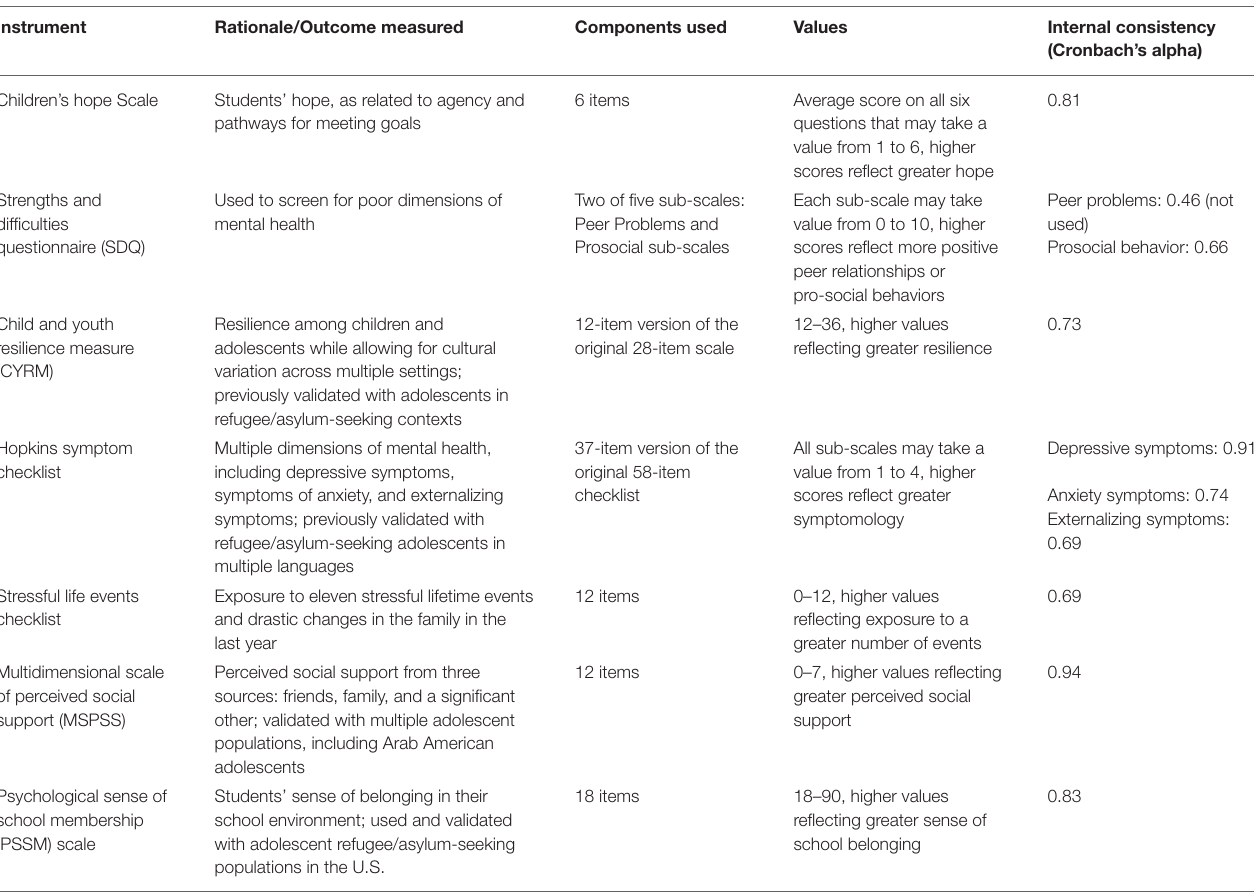
TABLE 1 | Outcomes of